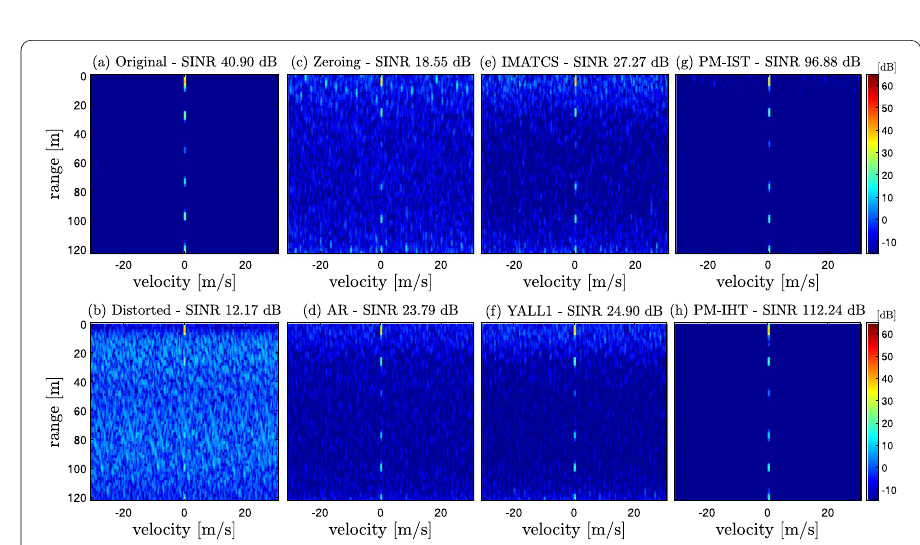
Fig. 4 a Original RD spectrum, b Distorted RD spectrum and RD spectra recovered by c the zeroing method, d AR, e IMATCS, f YALL1, g PM-IST, and h PM-IHT, in the case that the number of discarded samples is about 10% of the total